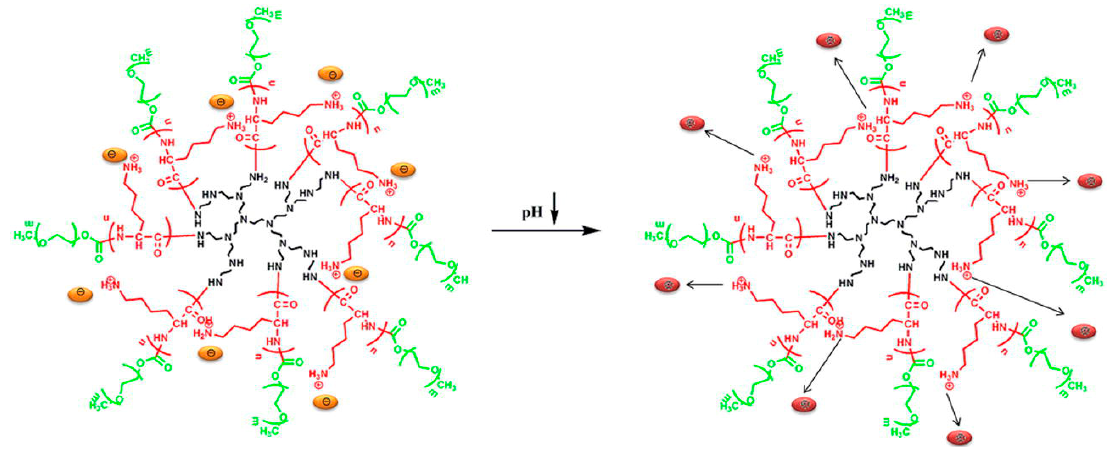
Figure 40. Chemical structure of the hydrophilic star block co-polymers and their use as protein nanocarrier developed by Yan et al. Reproduced with permission from reference [192].